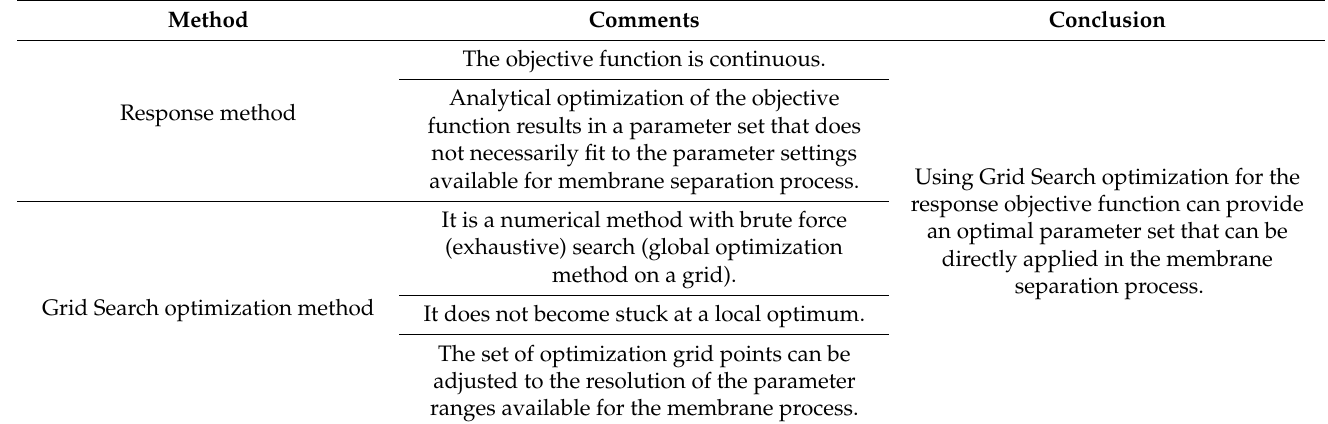
Table 4. Aspects and comments on Grid Search optimization method applied for response objective